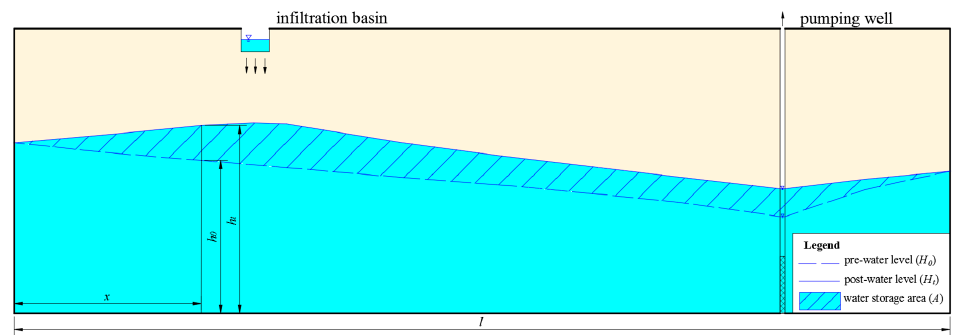
Figure 3. Water storage area calculation method.